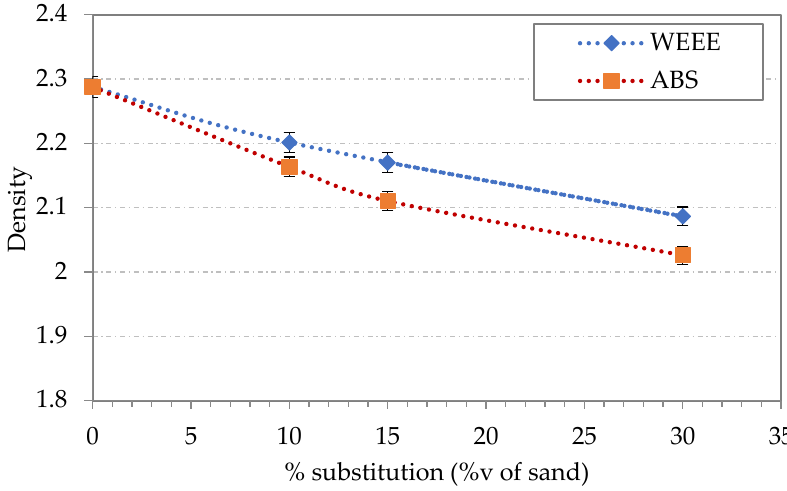
Figure 6. Density of mortars specimens as a function of volume substitution of sand by plastic aggregates.